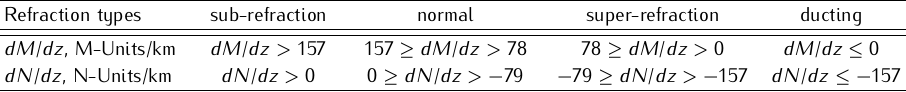
Table 1. Types of refractive